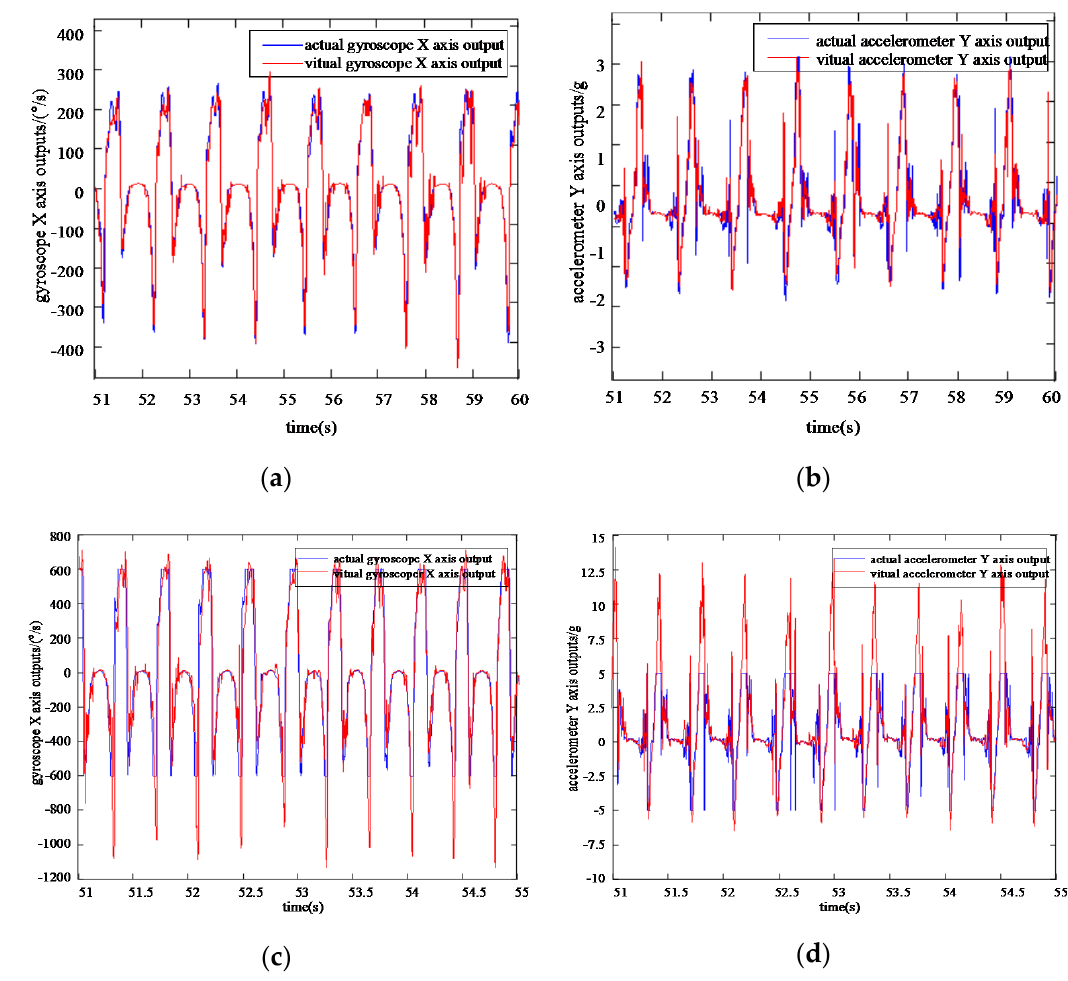
Figure 10. Virtual and actual IMU data under the walking velocity of 1 and 2.5 m/s: ( a ) X axis virtual and actual gyroscope outputs with a walking velocity of 1 m/s; ( b ) Y axis virtual and actual accelerometer outputs with a walking velocity of 1 m/s; ( c ) X axis virtual and actual gyroscope outputs with a walking velocity of 2.5 m/s; ( d ) Y axis virtual and actual accelerometer outputs with a walking velocity of 2.5 m/s.